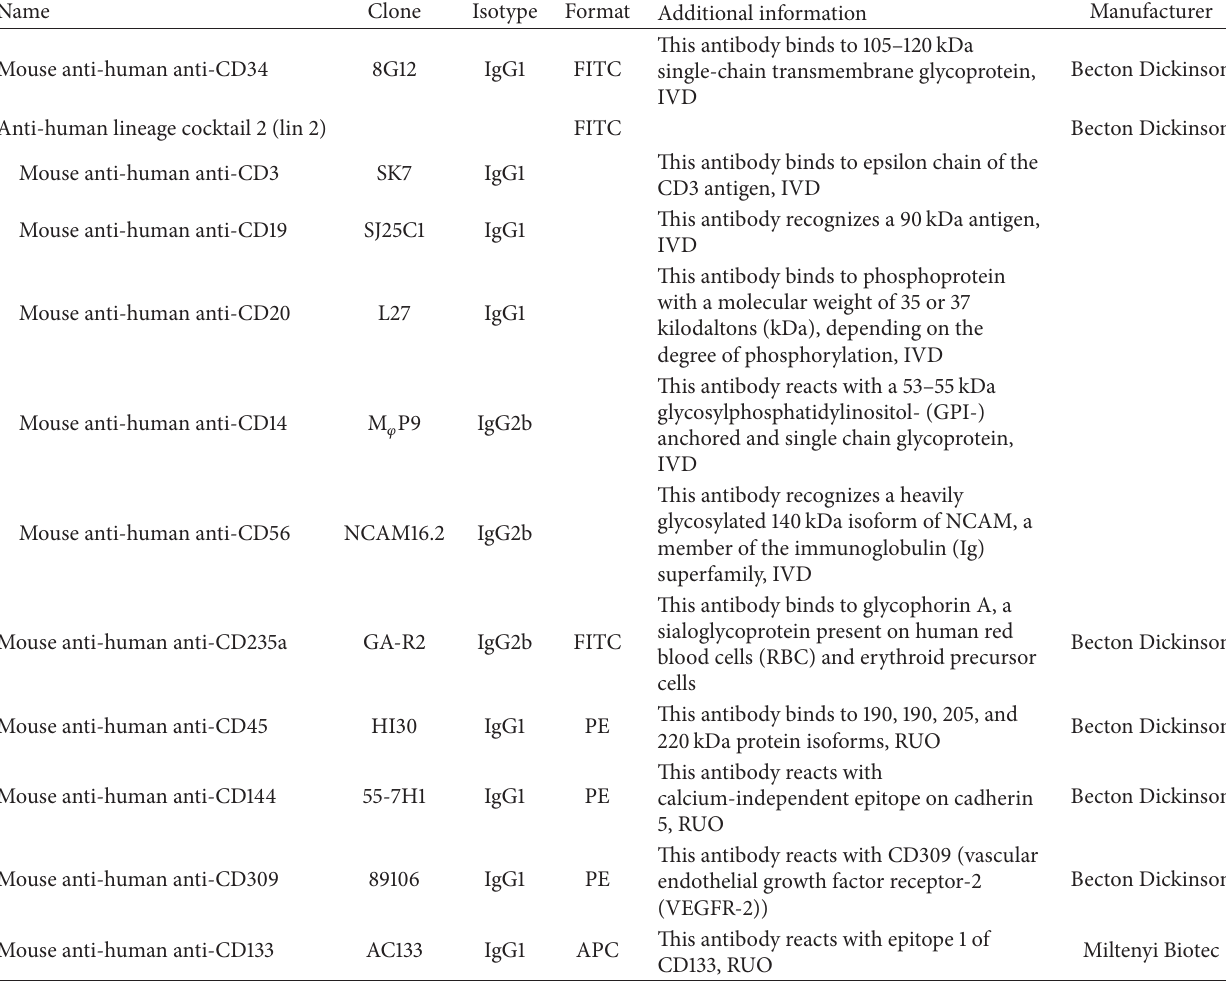
Table 2: Detailed characteristics of monoclonal antibodies used in the